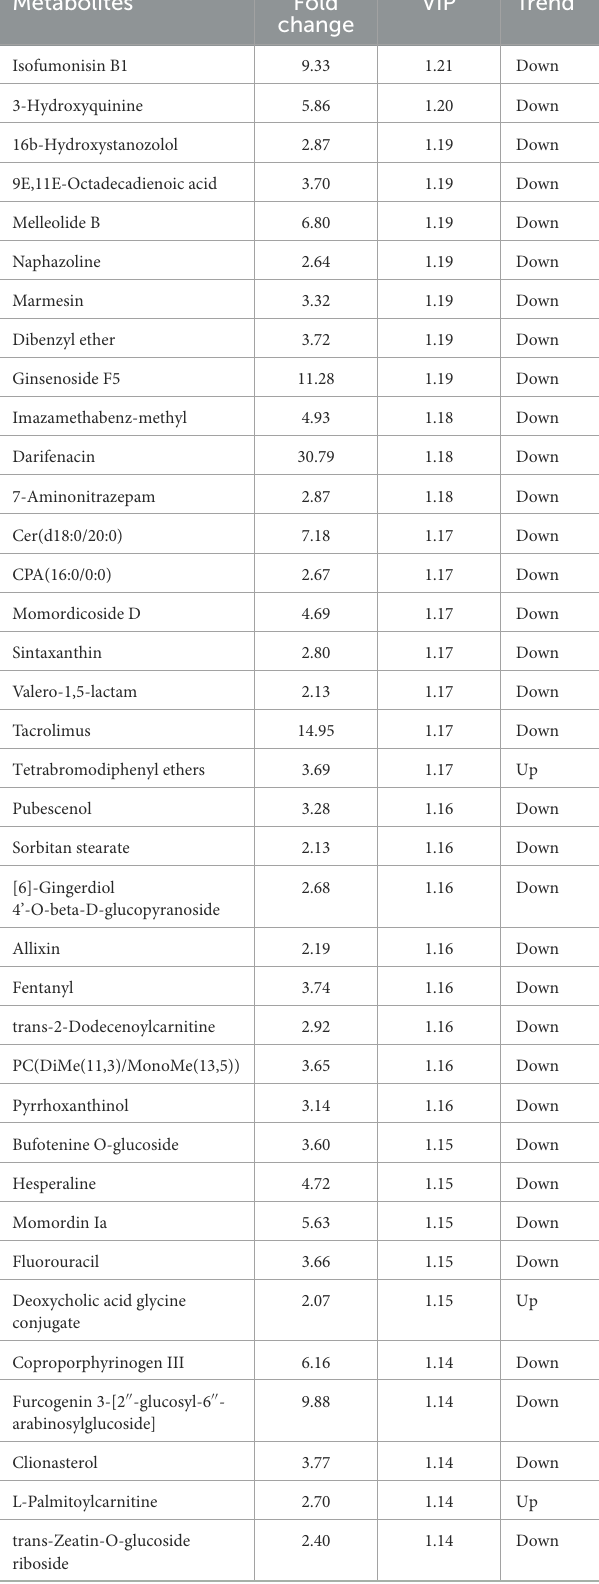
TABLE 1 Statistical analysis of differential metabolites between thiram-exposed and control groups. Metabolites Fold